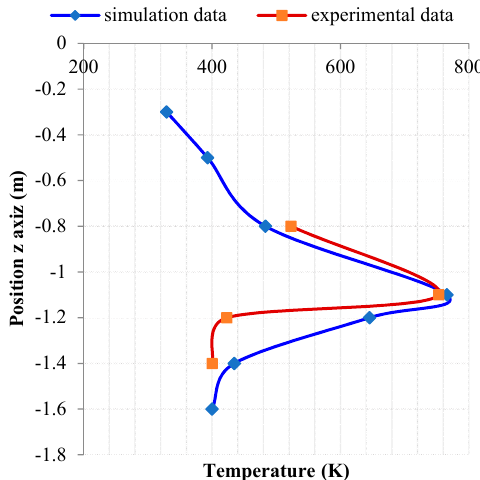
Figure 9. Temperature variation along the mid-axis of the gasifier simulation values vs. experimental values.